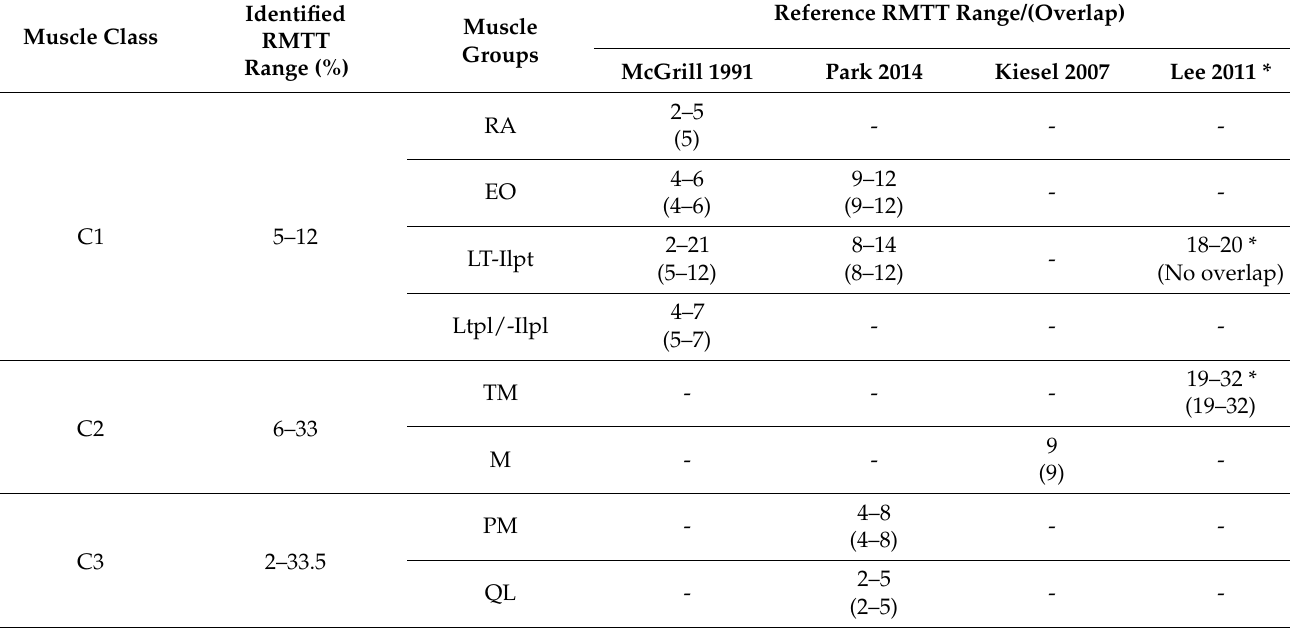
Table A2. Comparison of results with published reference